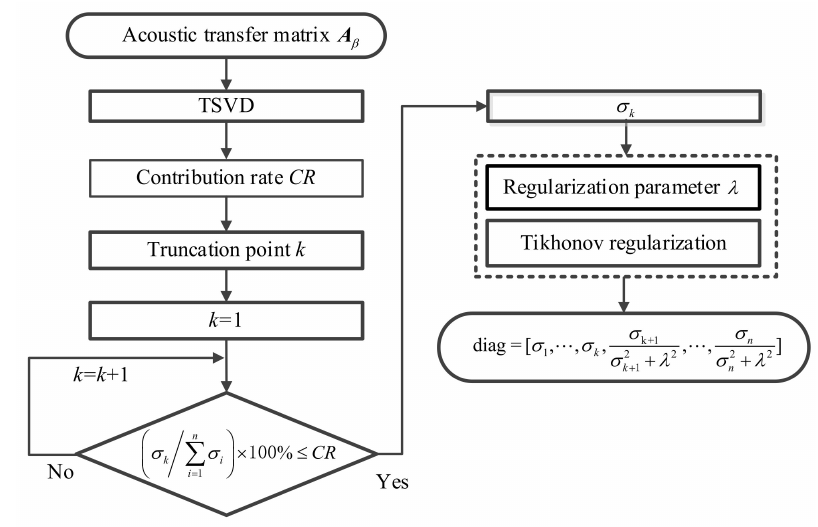
Figure 4. Schematic diagram of combined regularization